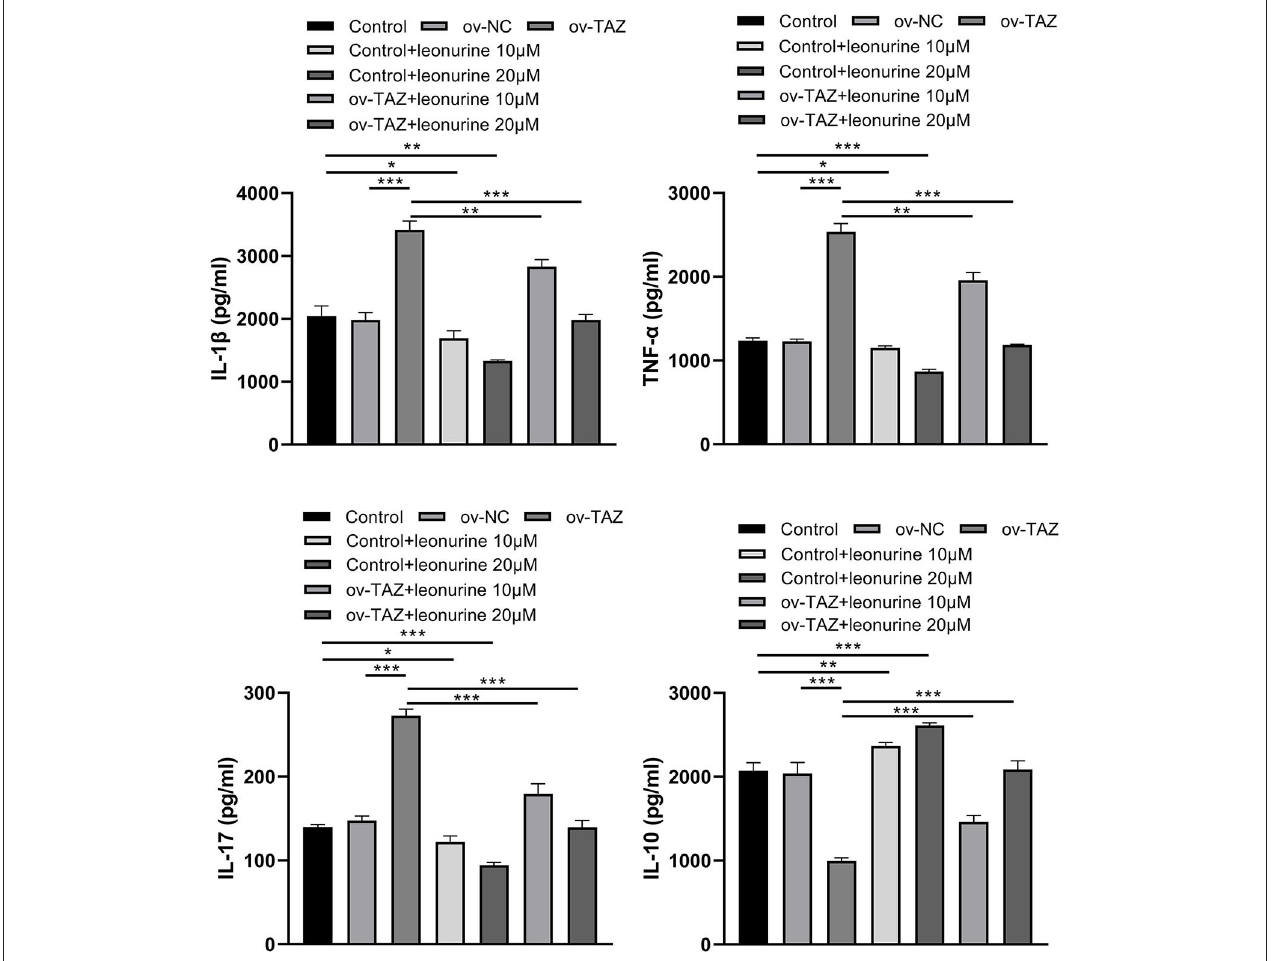
FIGURE 4 | ELISA assay showing TAZ-mediated inflammatory cytokine production by CD4 + T cells and suppression by leonurine. Compared with those in the ov-NC group or NC group, the protein levels of the pro-inflammatory cytokines IL-17, IL-1 β , and TNF- α in the ov-TAZ group increased, whereas those of the anti-inflammatory cytokine IL-10 decreased. After leonurine treatment, the protein levels of IL-17, IL-1 β , and TNF- α in the control group and ov-TAZ group decreased, whereas that of IL-10 increased. Results are expressed as average of 3 experiments. * P < 0.05, ** P < 0.01, and *** P < 0.001.